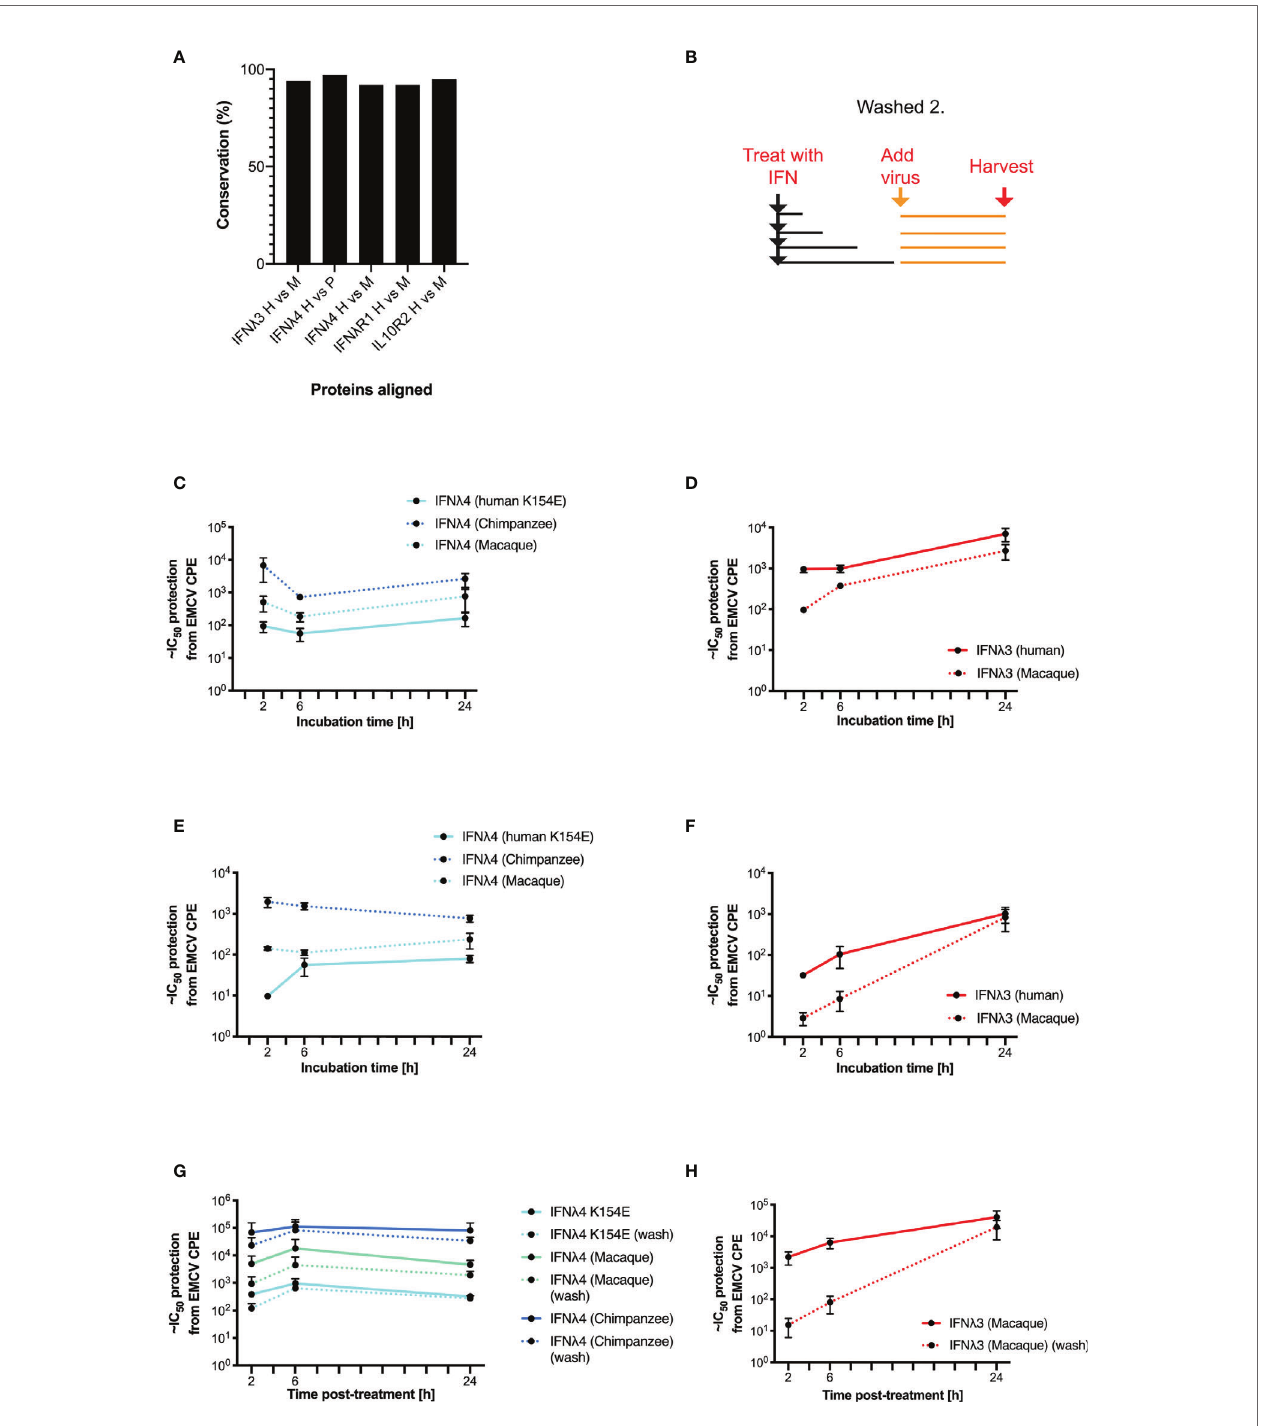
FIGURE 5 | Kinetics of antiviral activity of non-human primate IFN l s. The percentage identity of IFN l pathway proteins (IFN l 3, IFN l 4, IFN l R1, and IL10R2) between humans, chimpanzees, and/or macaques was measured using BLAST (A) . A washing/incubation protocol was used (B) and HepaRG (C , D , G , H) or rhesus macaque LL-CMK2 (E, F) cells were pretreated with IFN l 4 (C , E , G) or IFN l 3 (D, F, H) for the indicated times prior to infection with EMCV. Times 24 (HepaRG) or 72 (LL-CMK2) hours postinfection antiviral activity was measured by CPE assay. Antiviral activity of IFN l s on HepaRG cells was measured using the alternative washing protocol ( G , H outlined in Figure 4 ). Results are shown as mean ± SD from four biological replicates. Data for panels (A – F) were obtained using independent protein batches as panels (G, H)